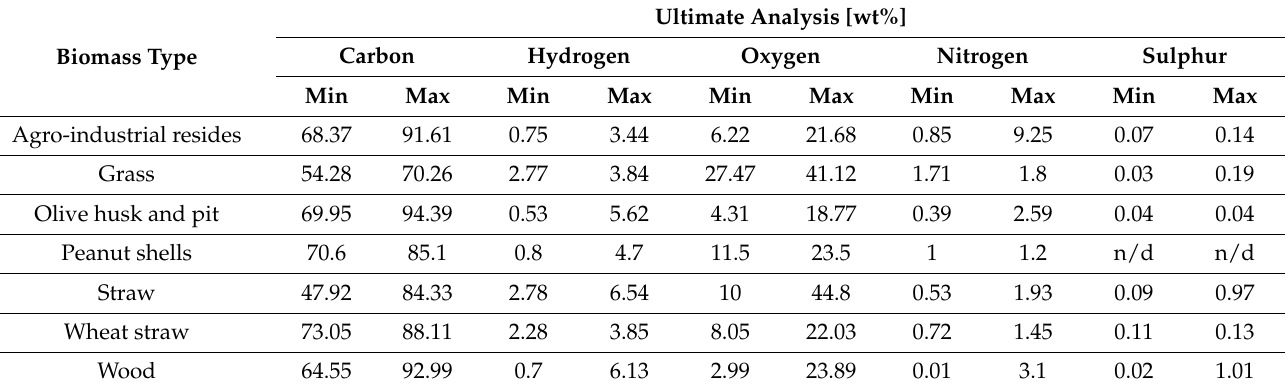
Table 1. Ultimate analysis of biochar from various biomass